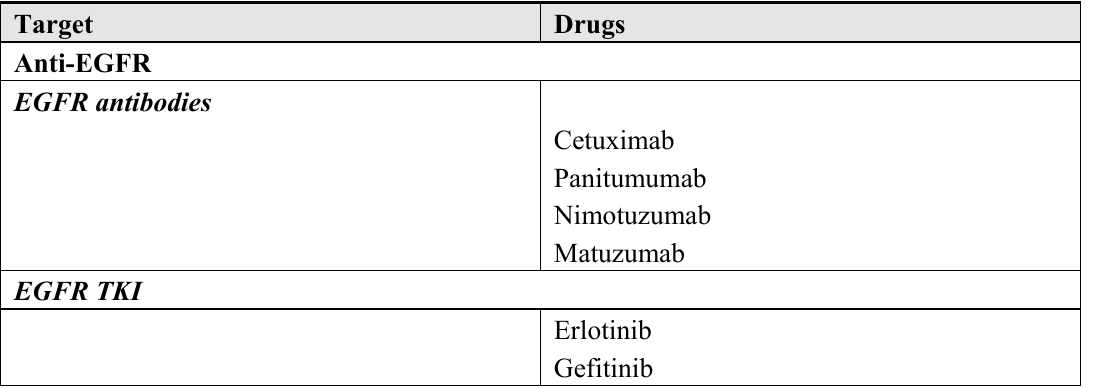
Table 1. Molecular targeted agents for gastric cancer and their